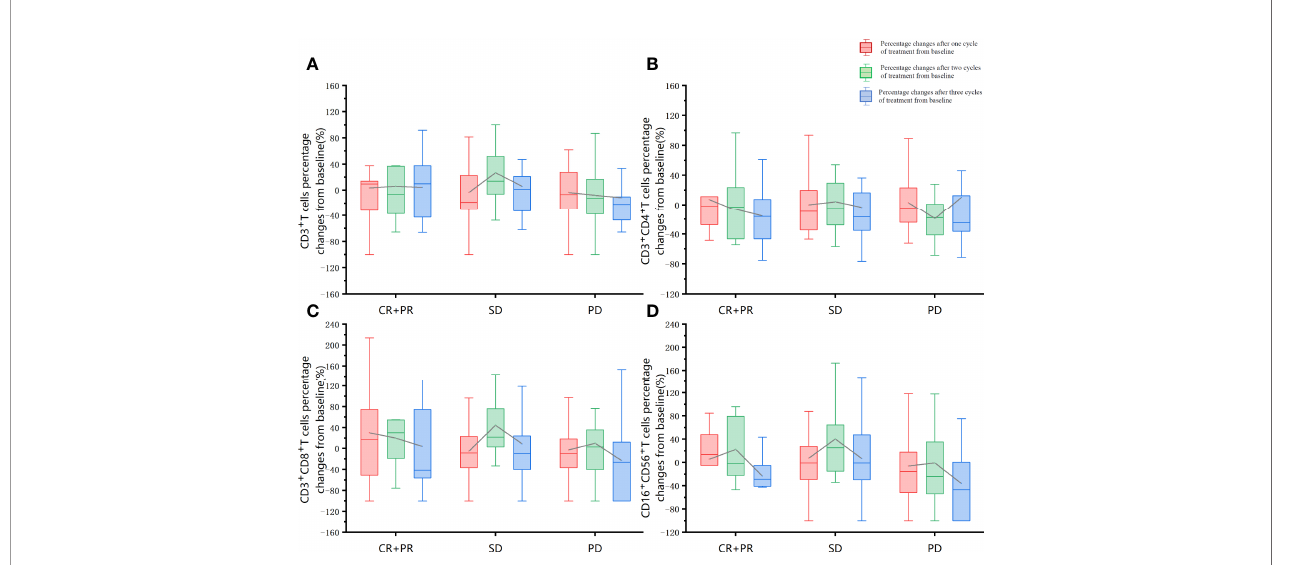
FIGURE 5 | Lymphocyte subset percentage changes after treatment from baseline between the three groups (CR+PR, SD, PD). The red boxplot represents percentage changes after one cycle of treatment from baseline. The green boxplot represents percentage changes after two treatment cycles from baseline. The blue boxplot represents percentage changes after three cycles of treatment from baseline. The differences in the proportion of changes after the fi rst cycle of treatment, after the second cycle of treatment, and after the third treatment cycle was compared separately between the three groups (CR+PR, SD, PD). The one-way ANOVA was used for the homogeneity of consistent variance, and the rank-sum test was used for the homogeneity of inconsistent variance. None of the other lymphocyte subset percentage changes showed statistical differences ( p > 0.05). (A) CD3 + T cells percentage changes from baseline. (B) CD3 + CD4 + T cells percentage changes from baseline. (C) CD3 + CD8 + T cells percentage changes from baseline. (D) CD16 + CD56 + T cells percentage changes from